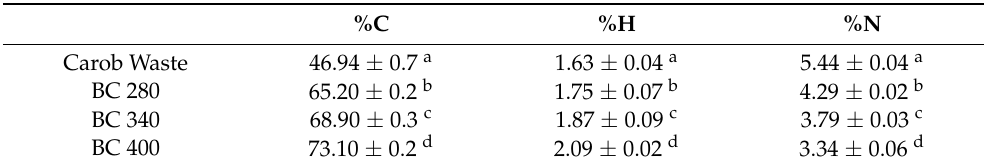
Table 1. Elemental composition of carob waste and biochar particles.